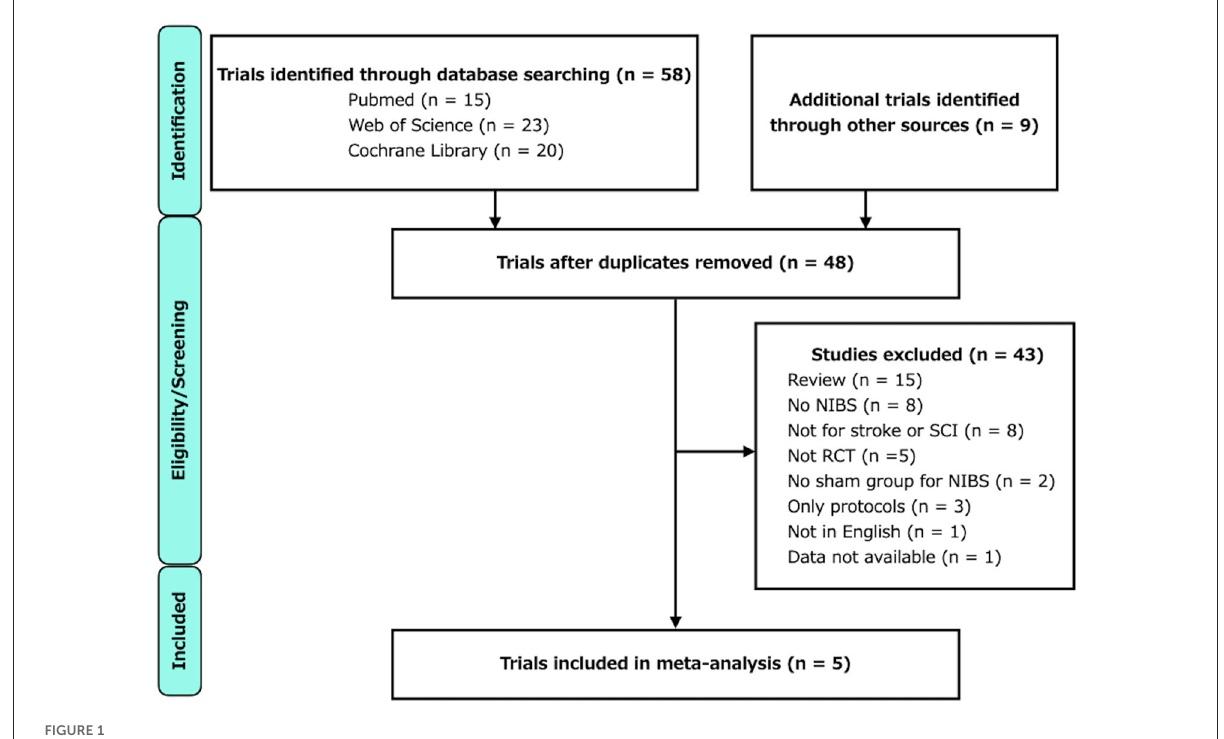
FIGURE1 Flowchart for trial